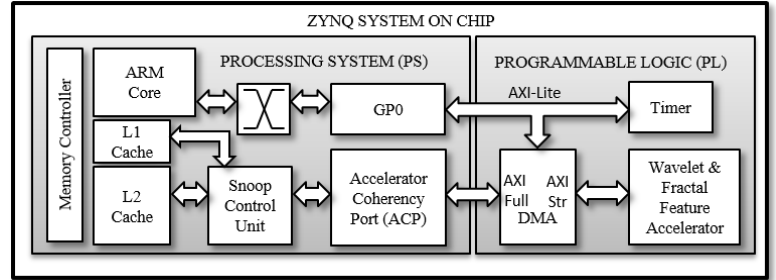
Figure 6. Zynq SoC design for a fall detection